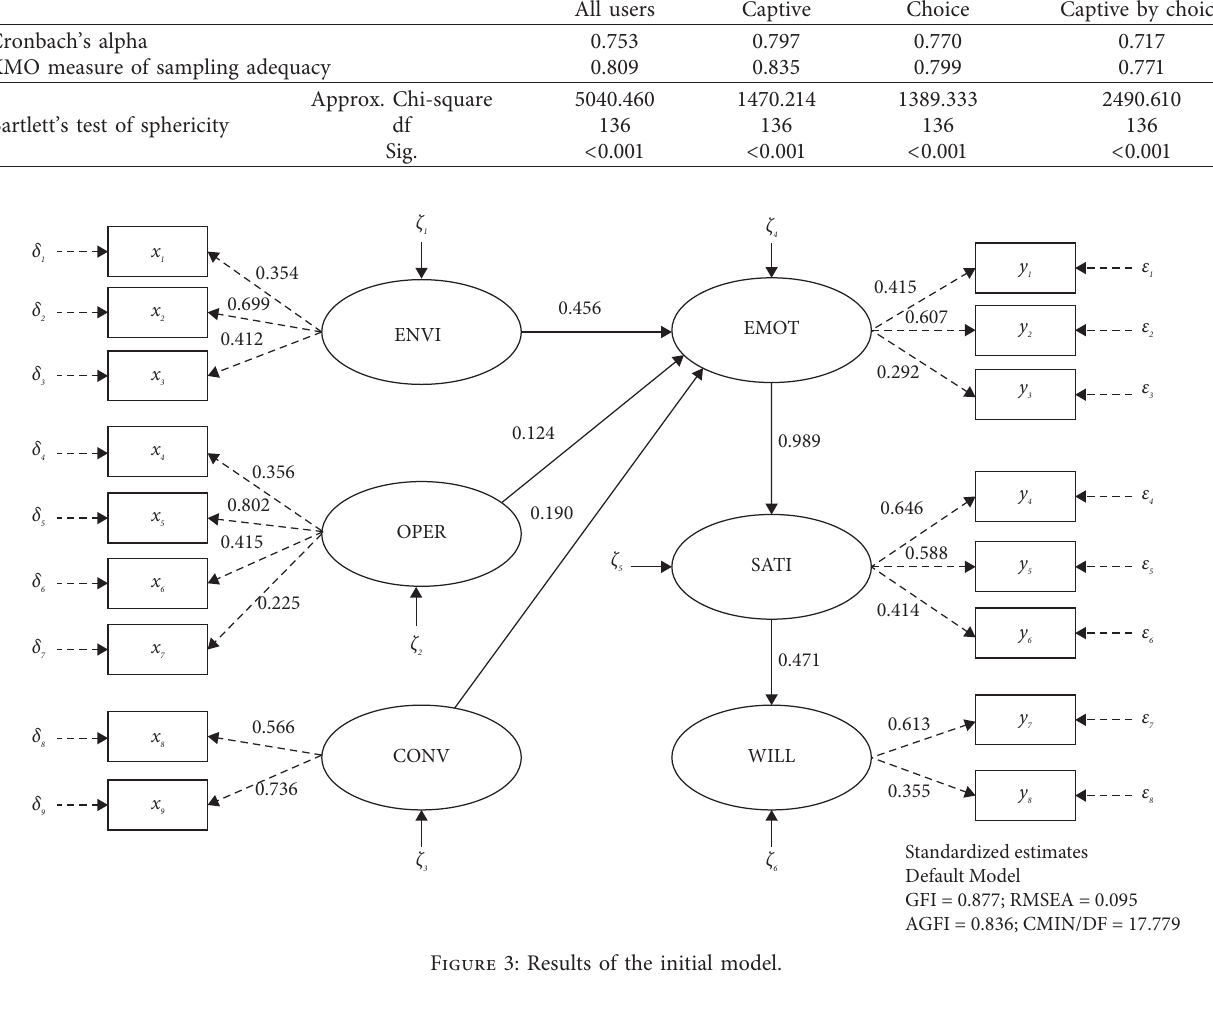
Figure 3: Results of the initial model.